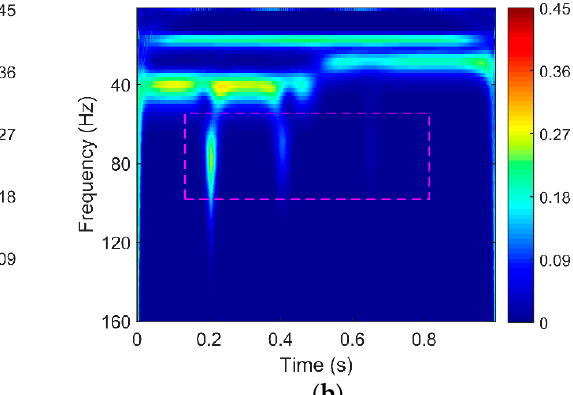
Figure 4. Instantaneous energy sections obtained based on: ( a ) the original TK; ( b ) the absolute value of the original TK; and ( c ) the FWEO.